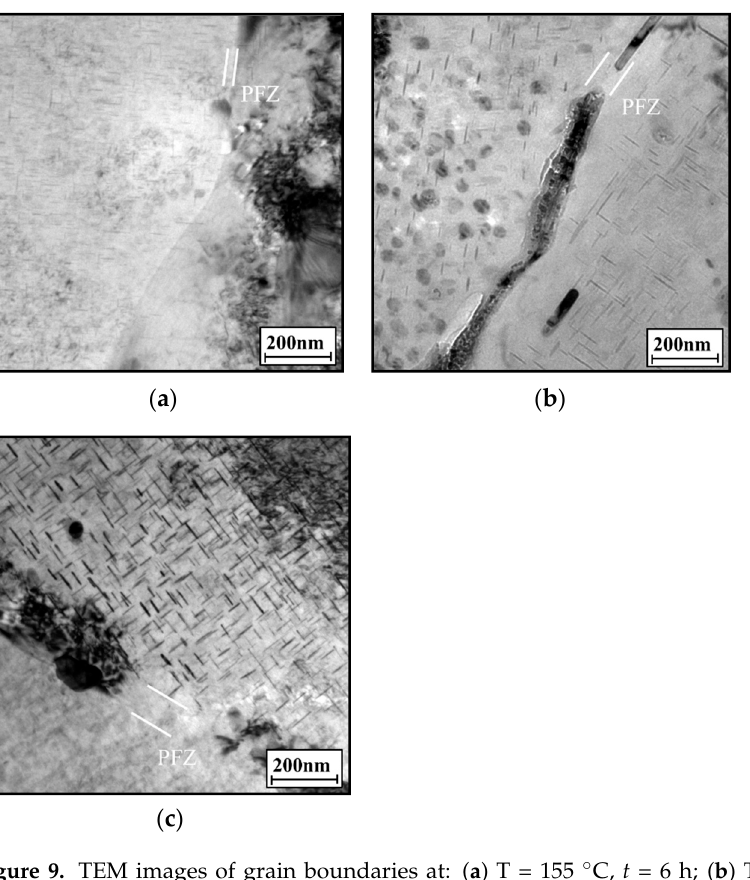
Figure 9. TEM images of grain boundaries at: ( a ) T = 155 °C, t = 6 h; ( b ) T = 155 °C, t = 24 h; ( c ) T = 175 °C, t = 24 h.